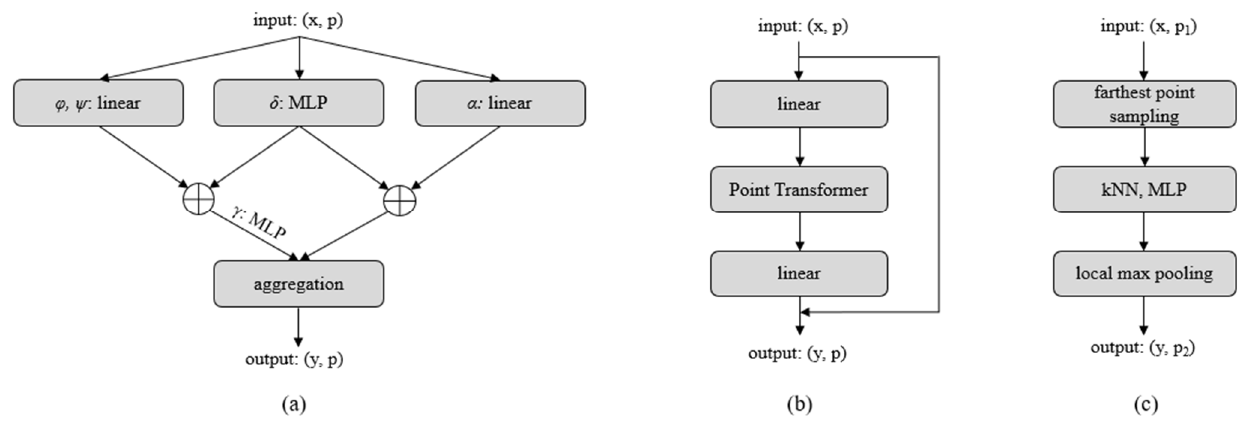
Figure 2. Network architecture of the transformer encoder comprises ( a ) point transformer layer, ( b ) point transformer block, and ( c ) transition down block.